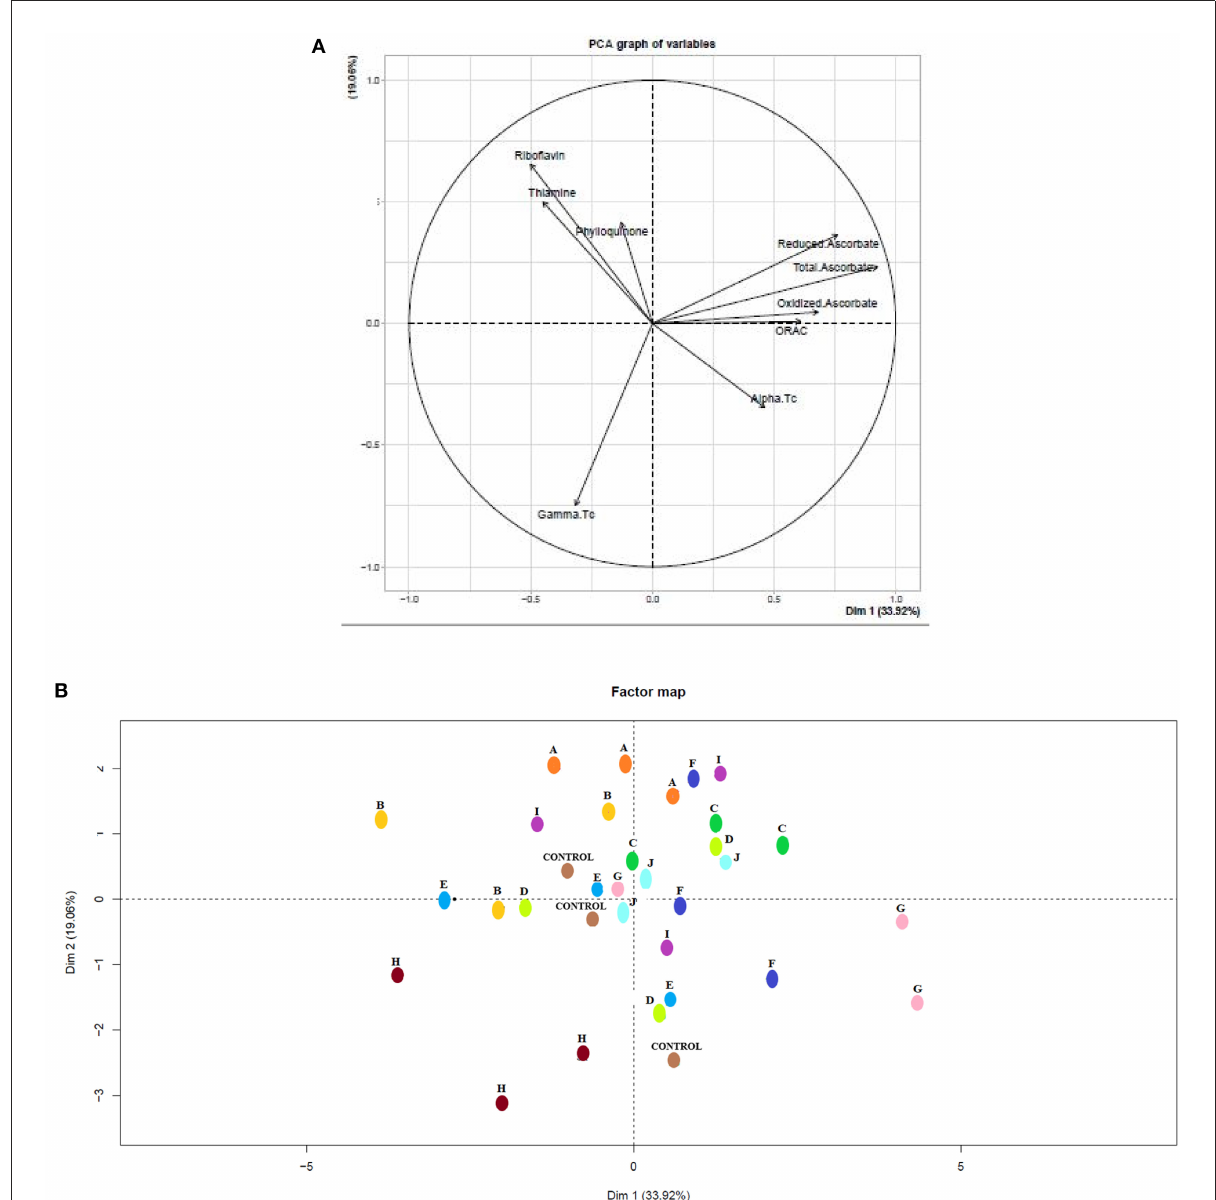
FIGURE3 Principal component analysis (PCA) plots. (A) Loading plot for different variables on PC1&PC2. The loading plots represent the original variables in the space of the PCs; they reveal the magnitude and direction of correlation of the original variables with the 1st and 2nd PCs. Measured variables were alpha-tocopherol, gamma-tocopherol, phylloquinone, thiamine, riboflavin, total ascorbate, reduced ascorbate, oxidized ascorbate, ORAC values. (B) PCA scores plot for basil samples on PC1 and PC2 marked in different colors in accordance. Basil inoculated with strains of A ( Plantibacter flavus ), B ( Plantibacter flavus ), C ( Curtobacterium flaccumfaciens) , D ( Methylobacterium oryzae) , E ( Sinorhizobium medicae ), Consortium F (A + B), G ( Rizhobium selenireductens ), H ( Curtobacterium herbarum ), I ( Bacillus toyonensis ), and J ( Bacillus fluminis